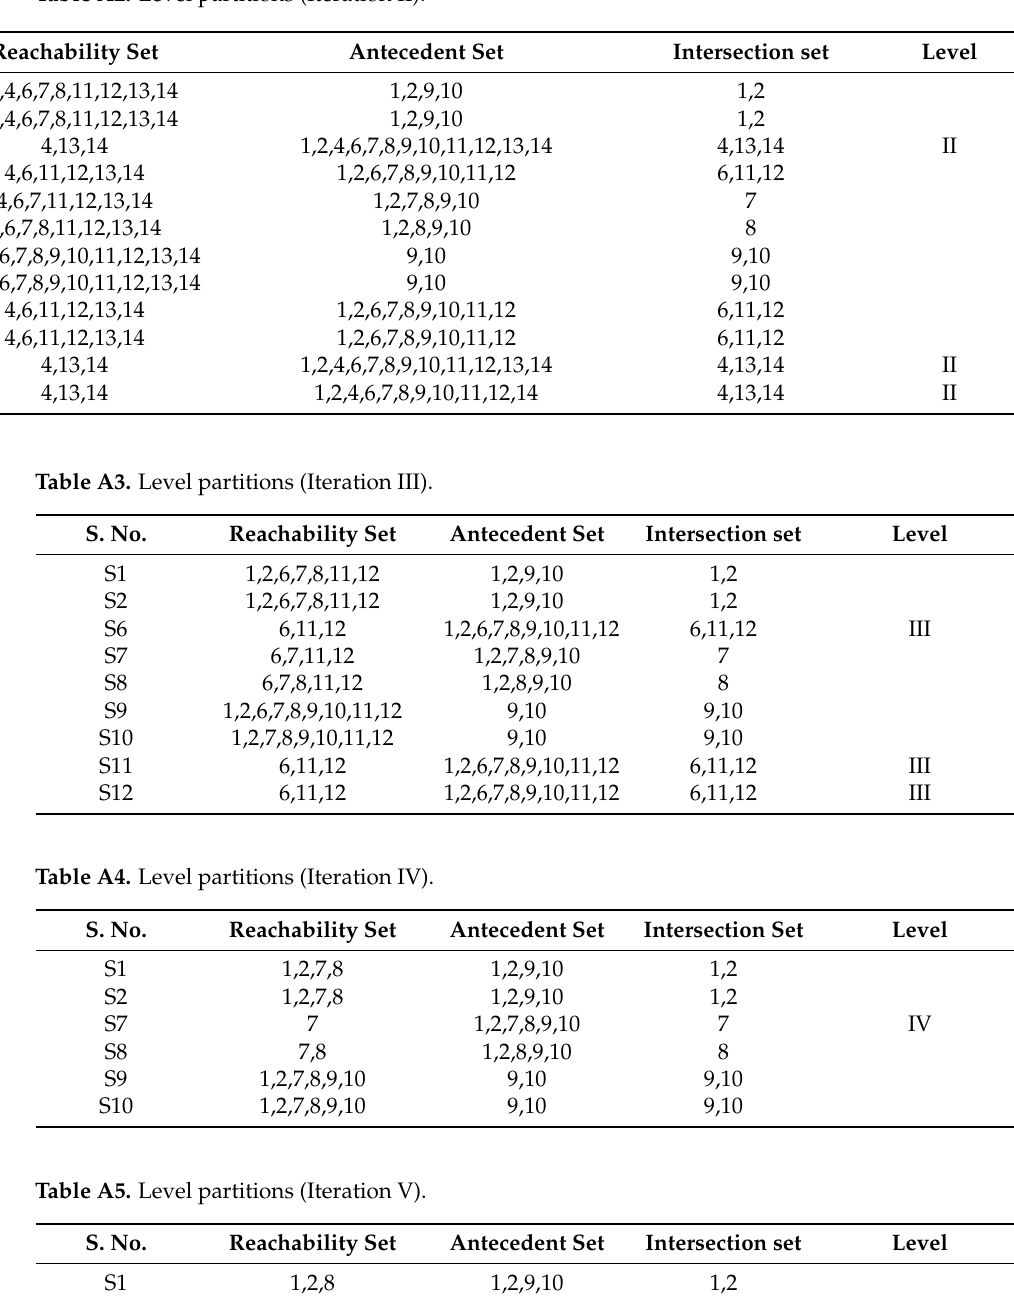
Table A2. Level partitions (Iteration II).